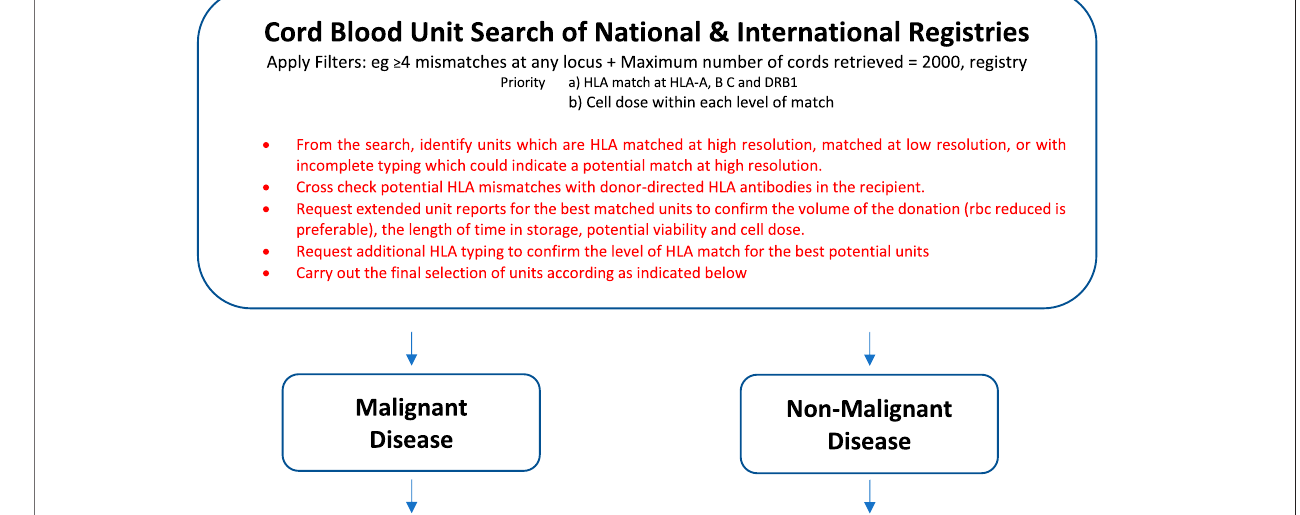
Frontiers in Cell and Developmental Biology |